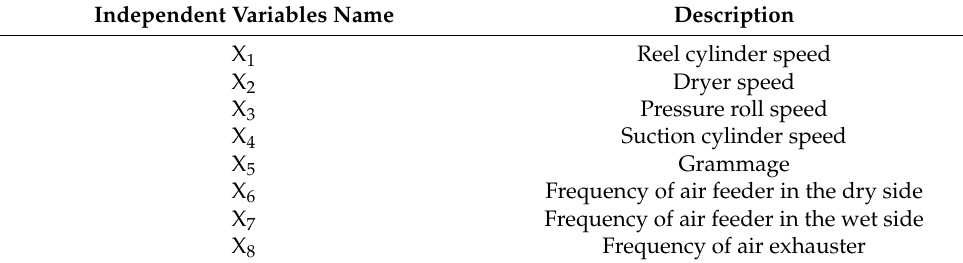
Table 1. Details of Dataset_1.